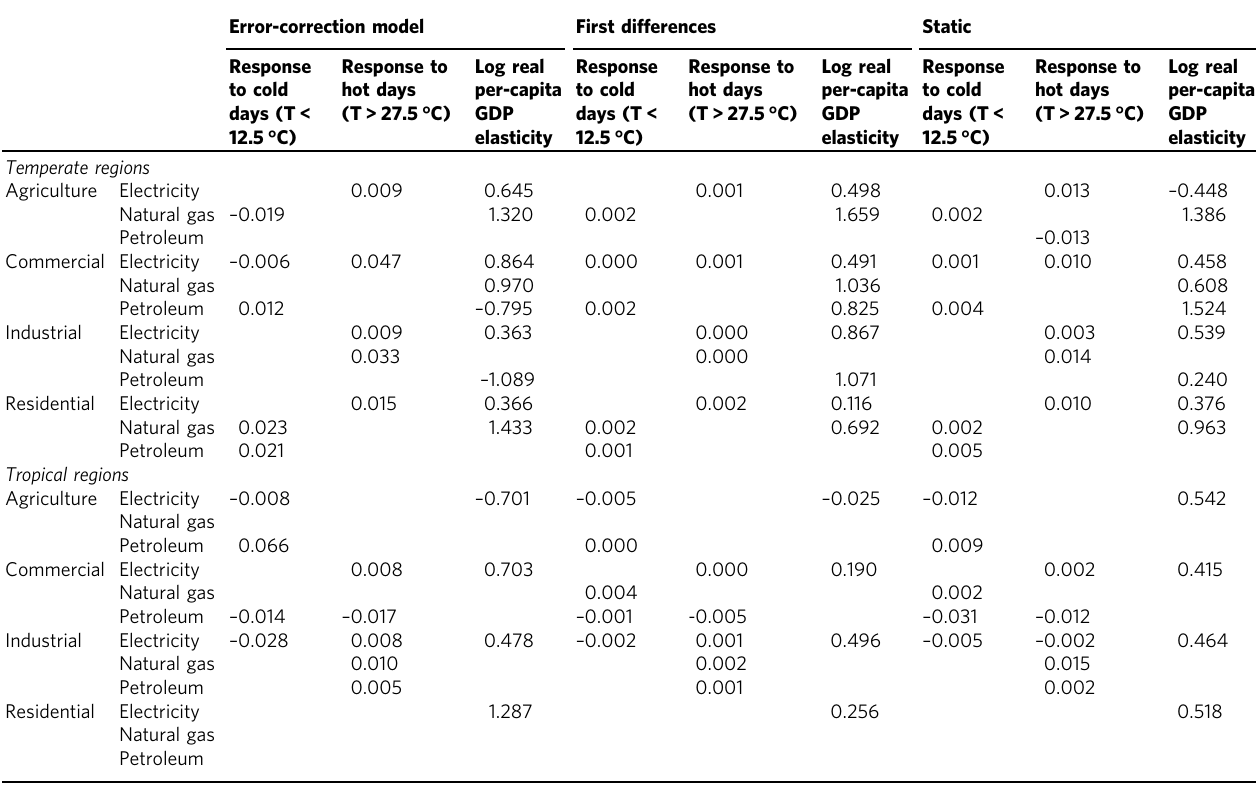
Table 2 Long-run estimated semi-elasticities and elasticities of energy demand to temperature and GDP per capita from DCSW